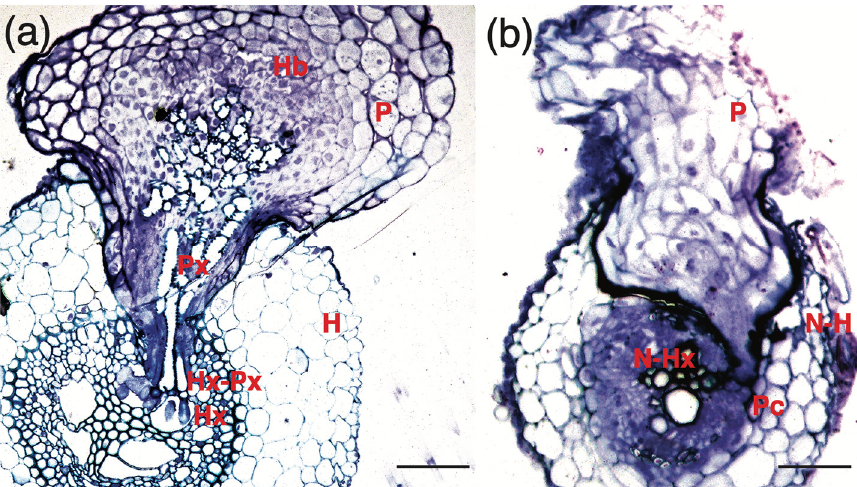
Figure 3. Post germination histological analysis of interactions between hosts and non-hosts. ( a ) Transverse section of compatible Striga -maize interaction showing a well-developed haustorium, establishment of Striga -host vascular connection (Px-Hx), parasite food storage organ – hyline body (Hb). Scale = 0.1 mm ( b ) Transverse section through unsuccessful parasitism in the landrace BMG234. The parasite is able to penetrate the non-host until it is inhibited at the pericyle. As a result, the parasite is not able to establish vascular connections with the non-host and subsequently dies. All interactions were determined 9 DAI. Scale = 0.1 mm. H = Host; P = Parasite; Hx = Host Xylem; Px= Parasite Xylem; Px-Hx = Host Xylem connected to Parasite Xylem.